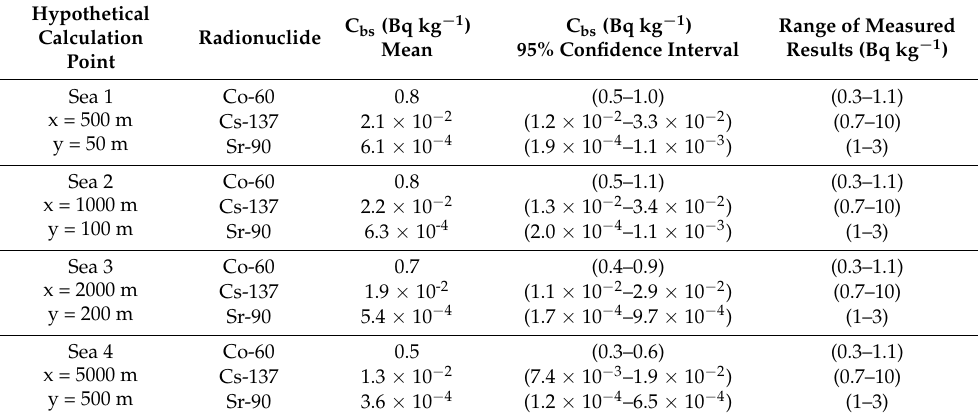
Table 3. Modelled results obtained for radionuclide concentrations in bottom sediments (C bs ) due to liquid releases from Vandell ó s II NPP and the range of reported measurement values